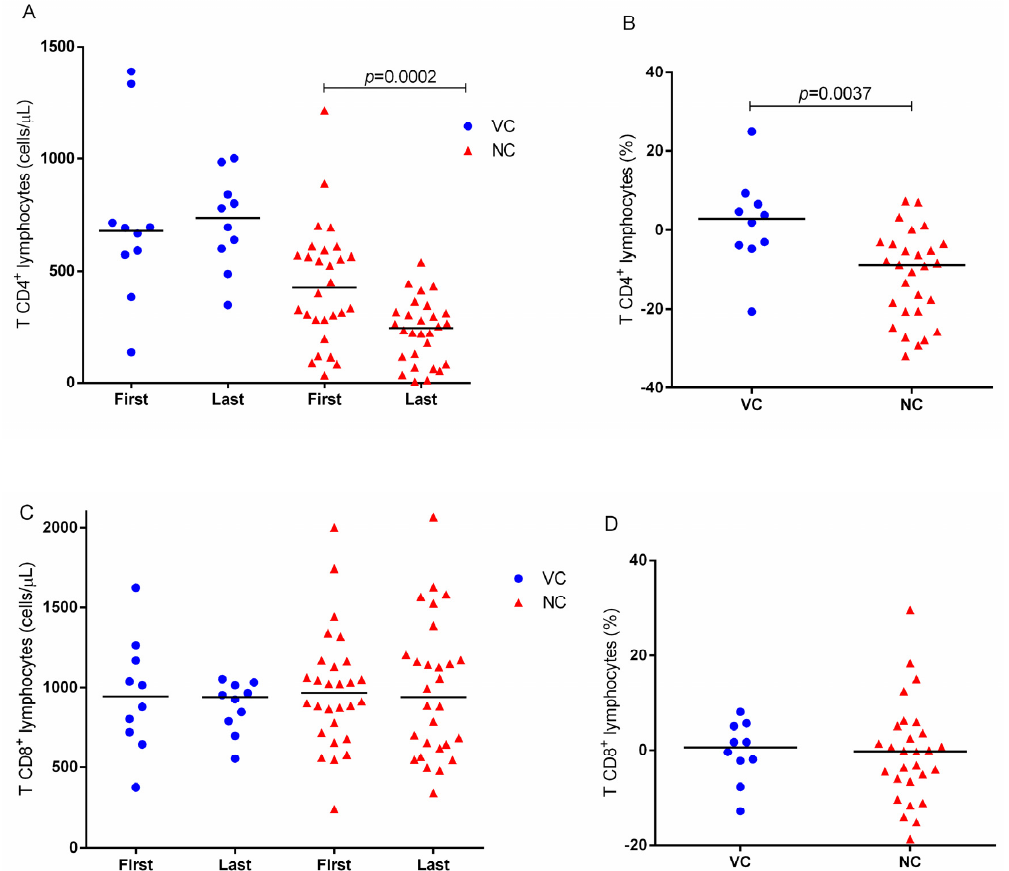
Figure 3. Longitudinal evolution of CD4+ TL and CD8+ TL counts in viremia controllers (VC) and non-controllers (NC). ( A ) Quantifications of CD4+ TL, absolute values. ( B ) Mean annual variation in the CD4+ TL count calculated by the compound annual growth rate (CAGR). ( C ) Quantification of CD8+ TL, absolute values. ( D ) Mean annual variation in the CD8+ TL count calculated by CAGR. CAGR was also calculated for CD4+ and CD8+ TL according to the studied gene var- iant to search for associations between disease progression and the genetic profile of the infected individual. There was a marked decrease in the CD4+ TL count in all the groups evaluated, but this decrease was only statistically significant in individuals with the pres- ence of the 3 ′ A allele variant (Figure 4A–C). The evolution of the CD8+ TL count according to the presence of gene variants was stable in all groups, with no significant differences (Figure 4D–F).